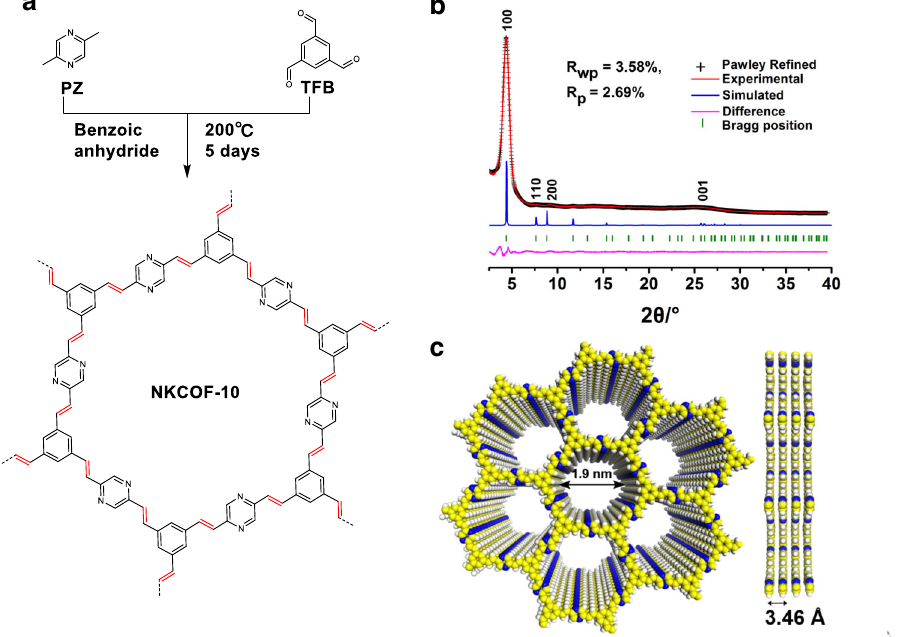
Fig. 2 Structure and crystallinity. a Structure and synthesis of NKCOF-10. b PXRD patterns of NKCOF-10: experimental patterns (red), pawley-re fi ned pro fi le (black), the simulated pattern for eclipsed AA stacking mode (blue), and the re fi nement differences (pink). c Top and side views of the eclipsed AA- stacking